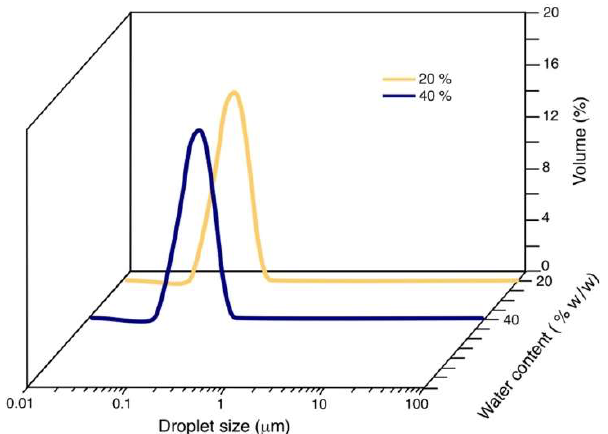
Figure 5. NE’s droplet size distribution as a function of water content for the dilution line S/O 55/45. Table 2 shows the droplet sizes D(0.5) in µ m for each of the NE formed in each dilution line. Table 2. Droplet size D(0.5) of the NE obtained.